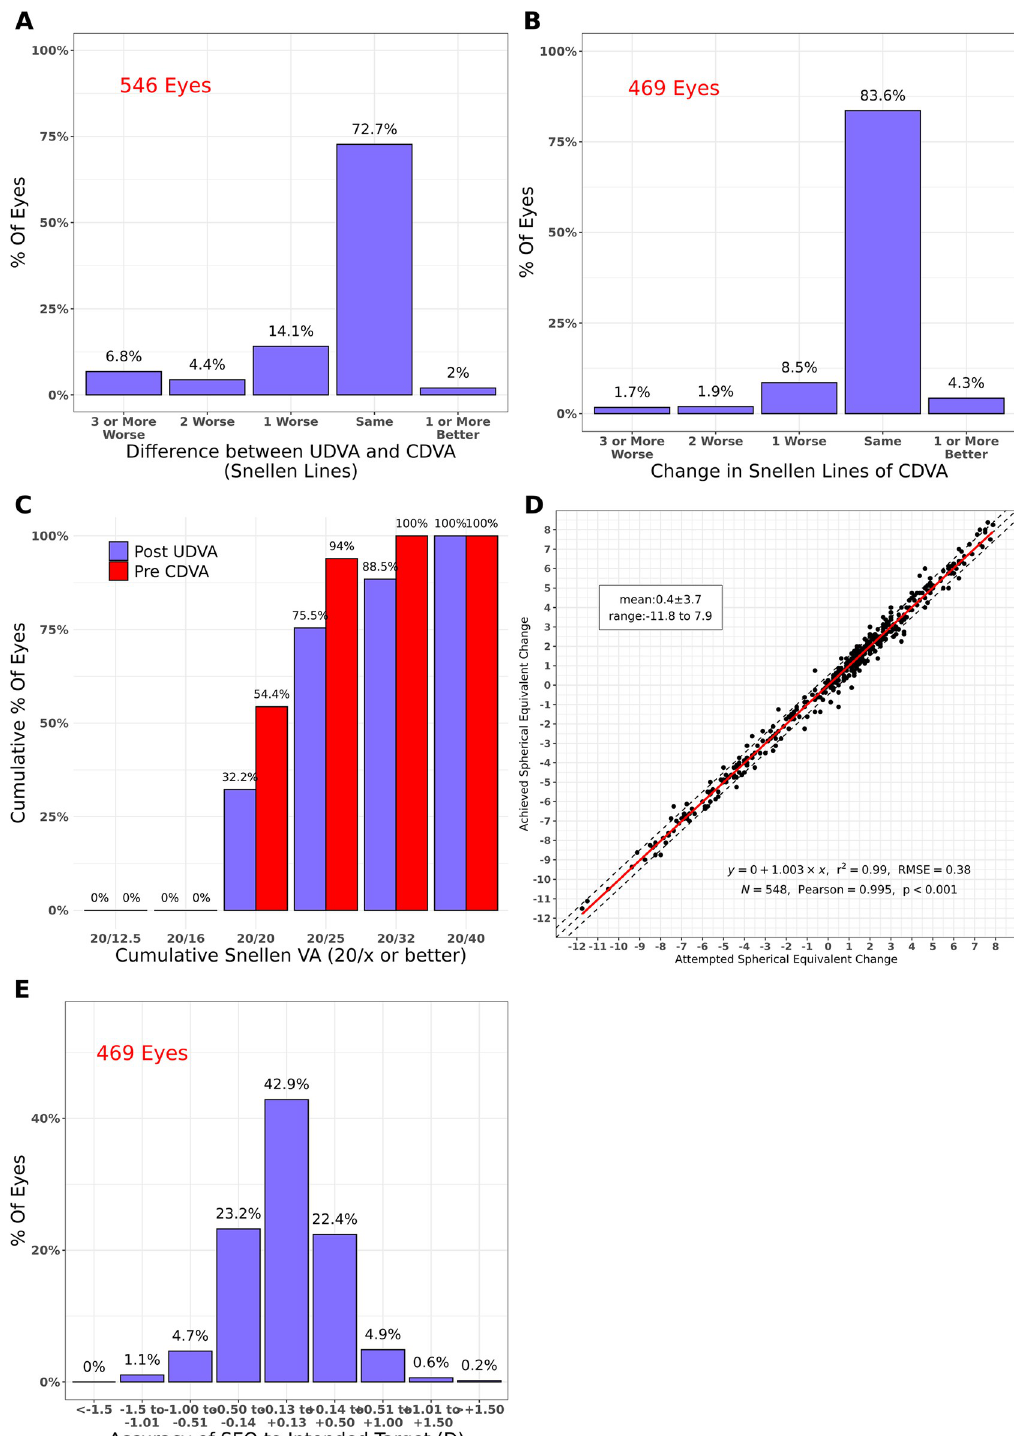
Fig 2. Standard graphs reporting visual outcomes: Preoperative vs postoperative (touch-up LASIK). UDVA: uncorrected distance visual acuity, CDVA: corrected distance visual acuity, VA: visual acuity, SEQ: spherical equivalent, D: diopter(s), r 2 : coefficient of determination, RMSE: root mean squared error, N: number of eyes, Pearson: Pearson Correlation Coefficient.